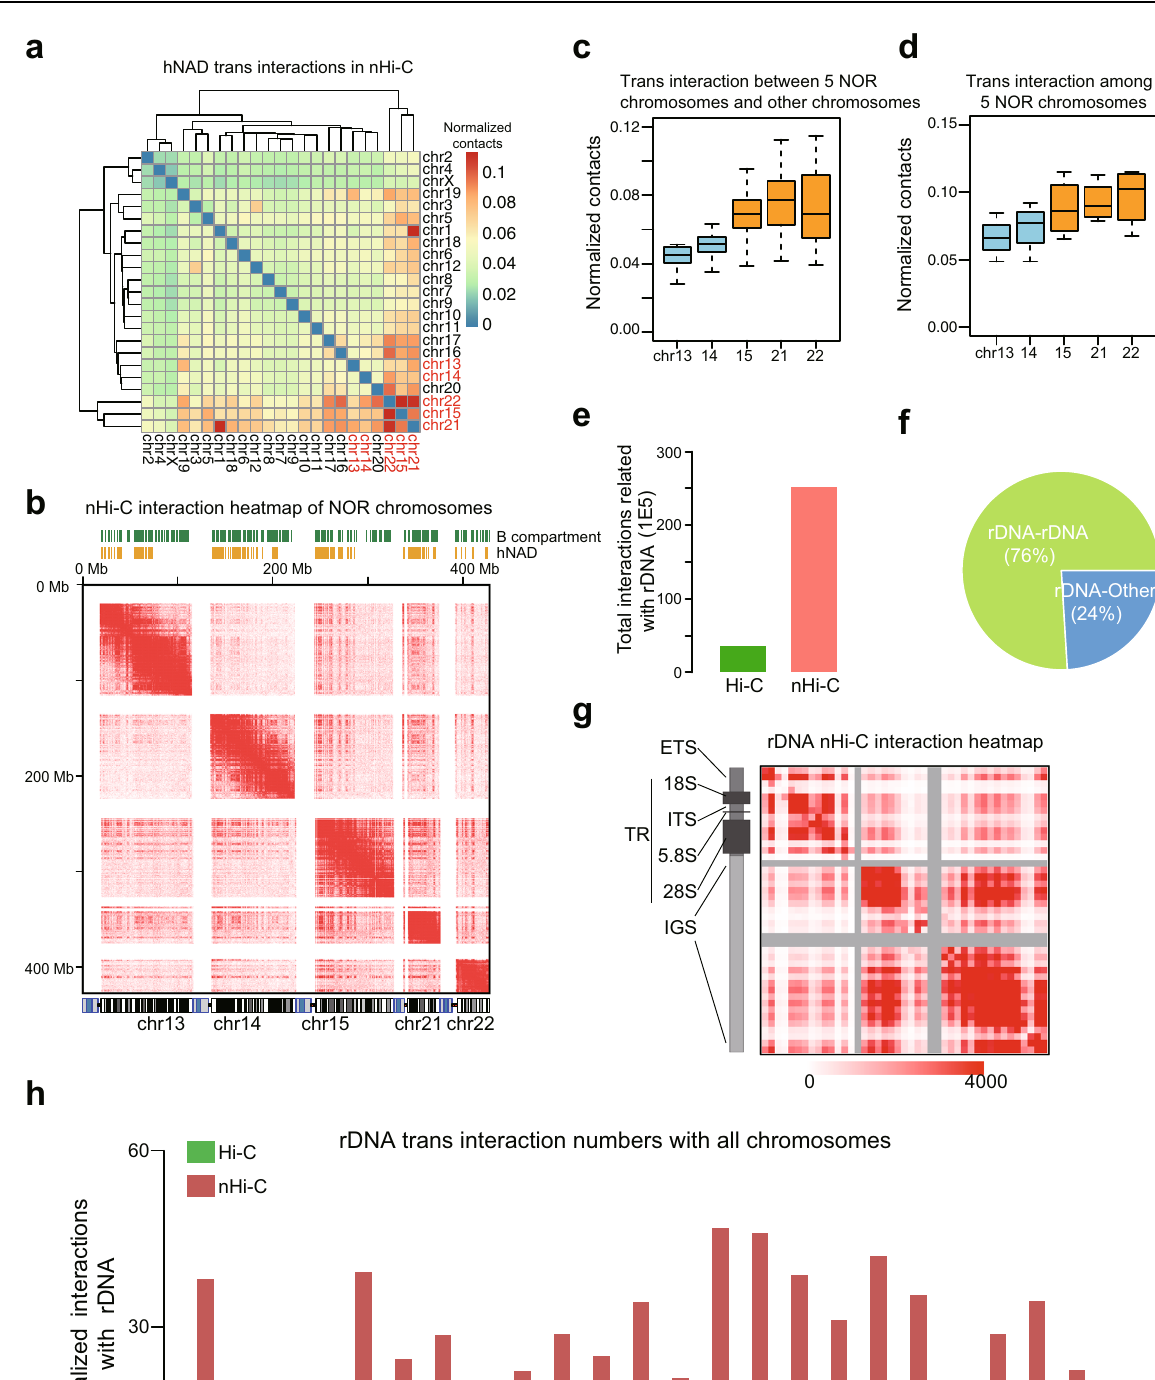
Fig. 3 | Deciphering nucleolus-associated interactions using nHi-C. a Chromosome clustering results of hNAD trans interactions captured by nHi-C. The 5 NOR-bearing chromosomes were labeled in red. b Interaction heatmap of NOR-bearing chromosomes. The bottom panel represents cytoband staining of chromosomes:rDNAarmsarecoloredinblue. c Box-plots(centerline,median;box limits, the 25th and 75th percentiles) of trans interactions between the 5 NOR- bearingchromosomesandotherchromosomes( n =22chromosomes). d Box-plots